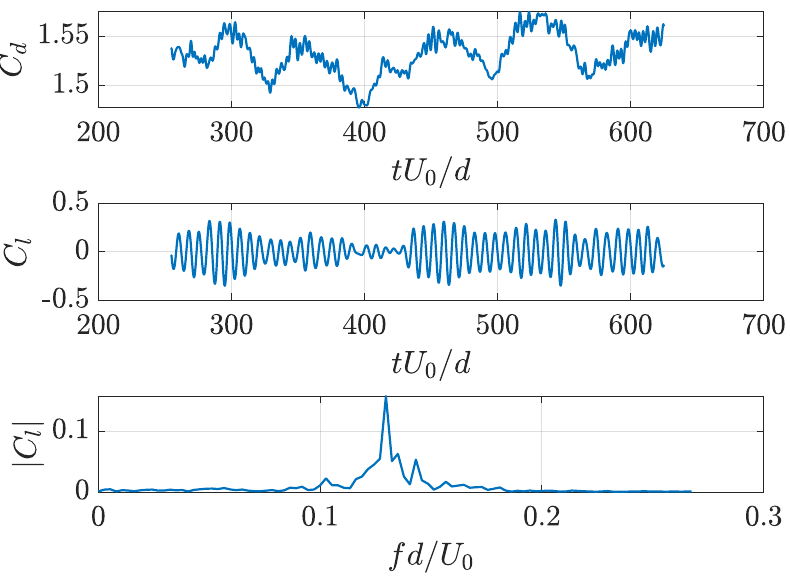
Figure 5. Time record of the drag coefficient ( top panel); time record of the lift coefficient ( middle panel); spectrum of the lift coefficient ( bottom panel). The values refer to the rigid case.